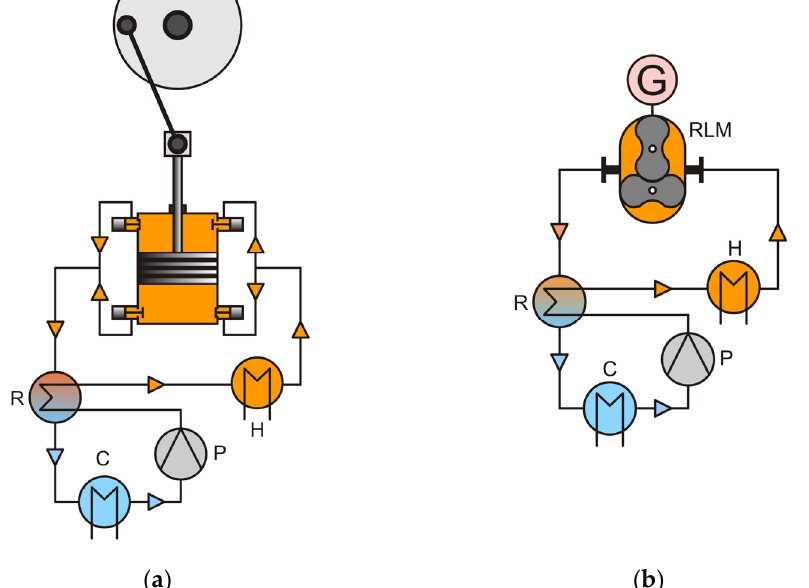
Figure 3. Worthington-type engine with crank gear ( a ). Worthington-type engine with rotary lobe machine ( b ). Pump (P), heater (H), recuperator (R), cooler (C) and rotary lobe machine